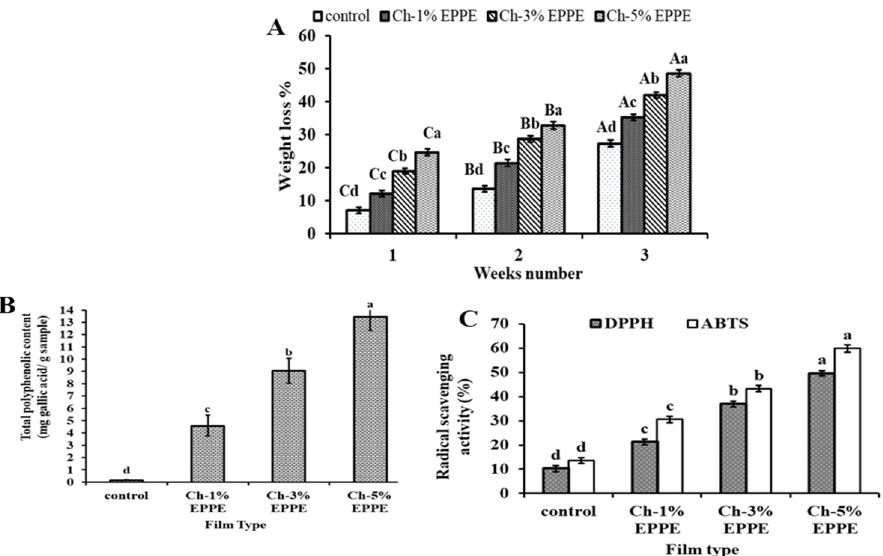
Figure 1. Biodegradability evaluation of chitosan films incorporated with EPPE ( A ), total phenolic content ( B ), and scavenging activities of the EPPE films on DPPH and ABTS radicals ( C ). Different letters indicate significant differences ( p < 0.05). Values are given as mean ( n = 3) ± SD.